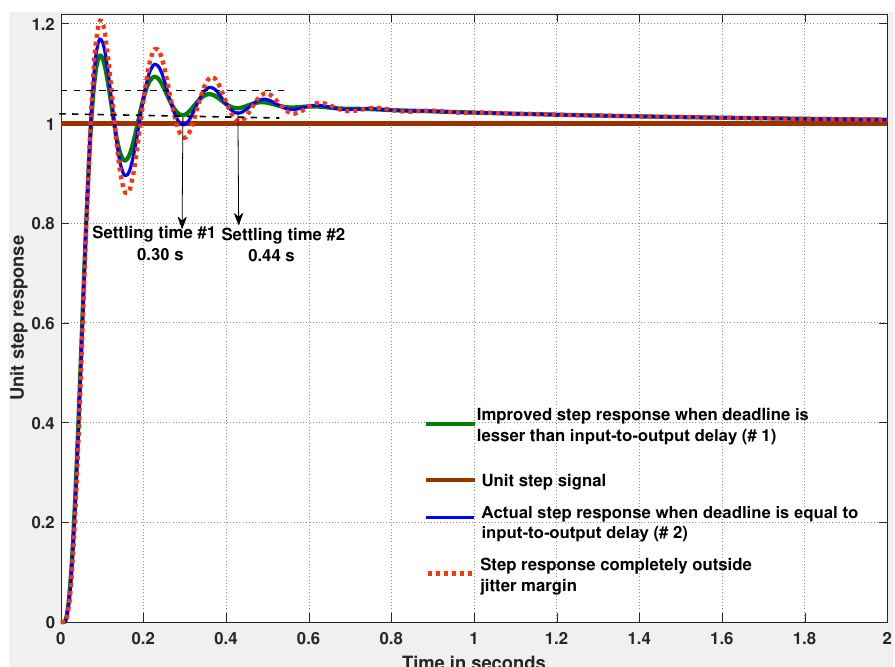
Figure 9. Control performance using step response for different deadline assignments: equal, less and greater than the input-to-output delay (resp. blue, green and red curves). The green curve (reduced overshoot one) is obtained with a deadline value equal to 8.2 ms chosen such that the settling time within 2% of the steady-state value is less than 0.3 s. When the control task deadline is greater than the jitter margin, logically the system performs poorer with increased oscillations and